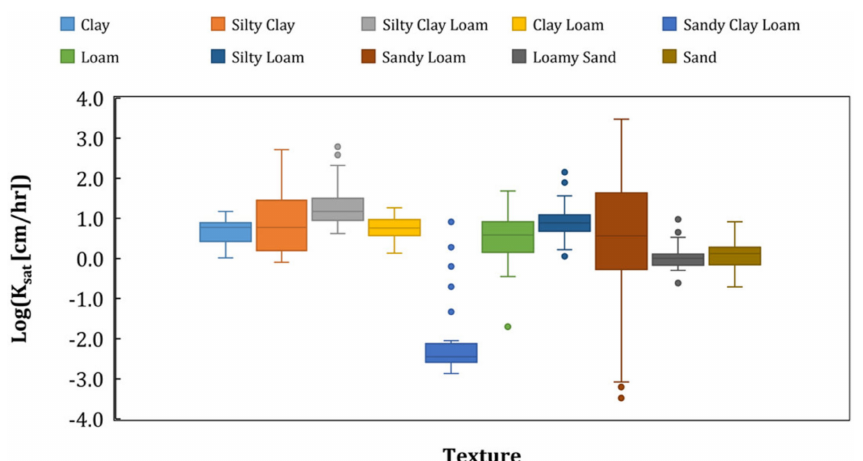
Figure 5. Hydraulic conductivity box plots for the different types of